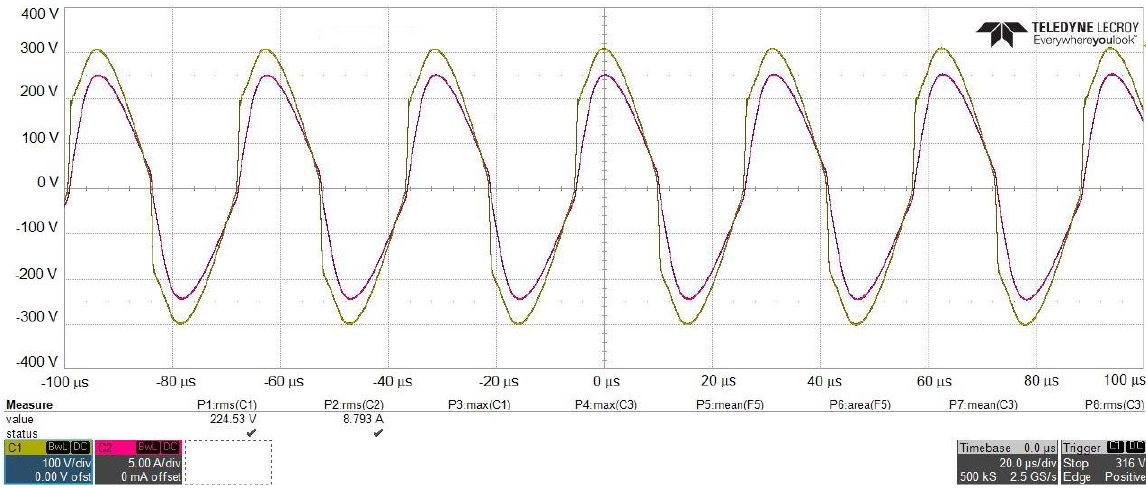
Figure 29. Receiver coil voltage (C1, green) and current (C2, purple) at 39 kHz.